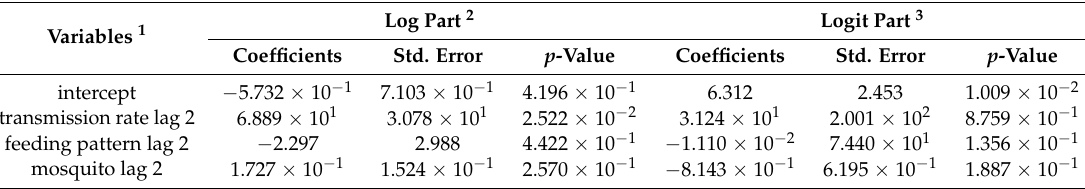
Table 2. Variables used in the WNV case model to predict the weekly human disease cases. Coefficients are the parameter estimate of each variable with standard deviation. p-Values show the significance of parameters in the